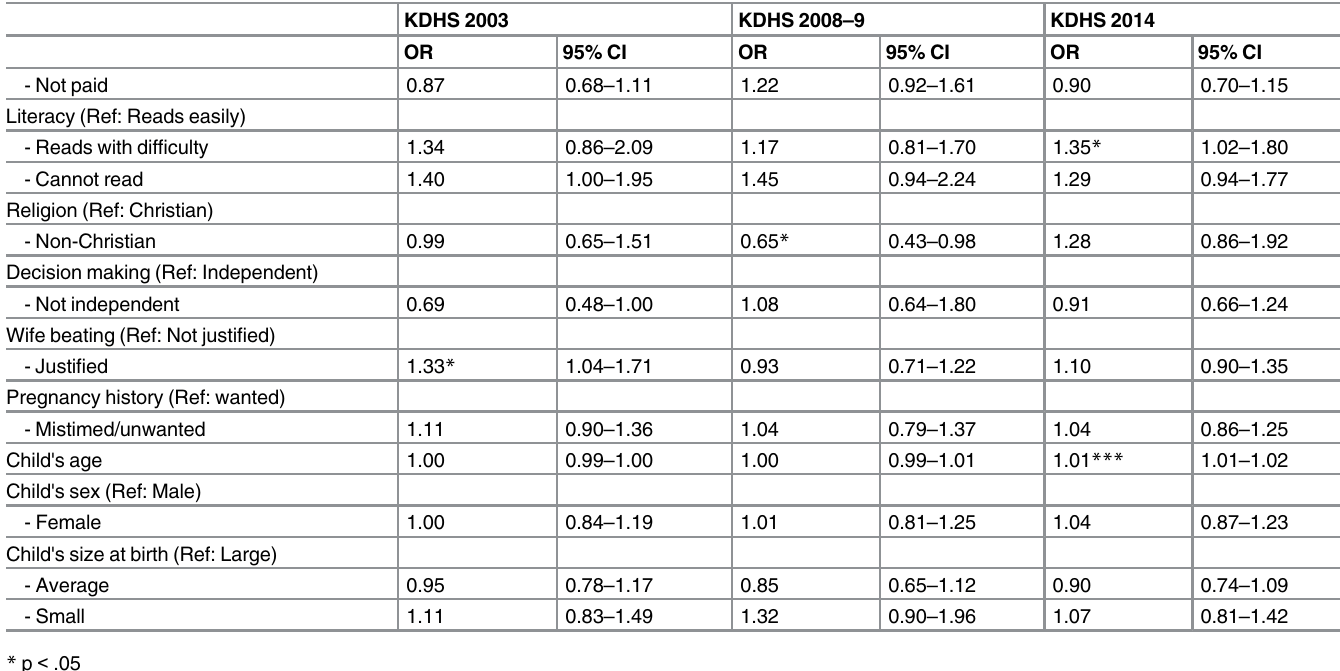
treated bed net. For example, comparing the richest against the poorest households shows that children in the poorest households had consistently higher odds of not sleeping under an insec- ticide treated bed net in 2003 (OR = 14.8, p < 0.001), 2008 – 9 (OR = 2.1, p < 0.05) and 2014 (OR = 2.3, p < 0.001). In relation to child ’ s age, the 2008 – 9 and 2014 data showed that an increase in the child ’ s age was associated with an increase in the odds of not sleeping under an insecticide treated bed net: 2008 – 9 (OR = 1.02, p < 0.001) and 2014 (OR = 1.01, p < 0.001). Table 6 shows logistic regression findings of the correlates of sanitary disposal of child's stool. Logit models 1 and 2 show that region of residence was a consistent predictor of sanitary disposal of a child ’ s stool. In 2014, households in all the other regions in Kenya were more likely to dispose their children ’ s stool in a toilet/latrine than households in Nairobi. Of signifi- cance is the change in odds between 2008 – 9 and 2014 in Rift Valley, Nyanza, Eastern and Coast regions. As compared to Nairobi region, households in the aforementioned regions